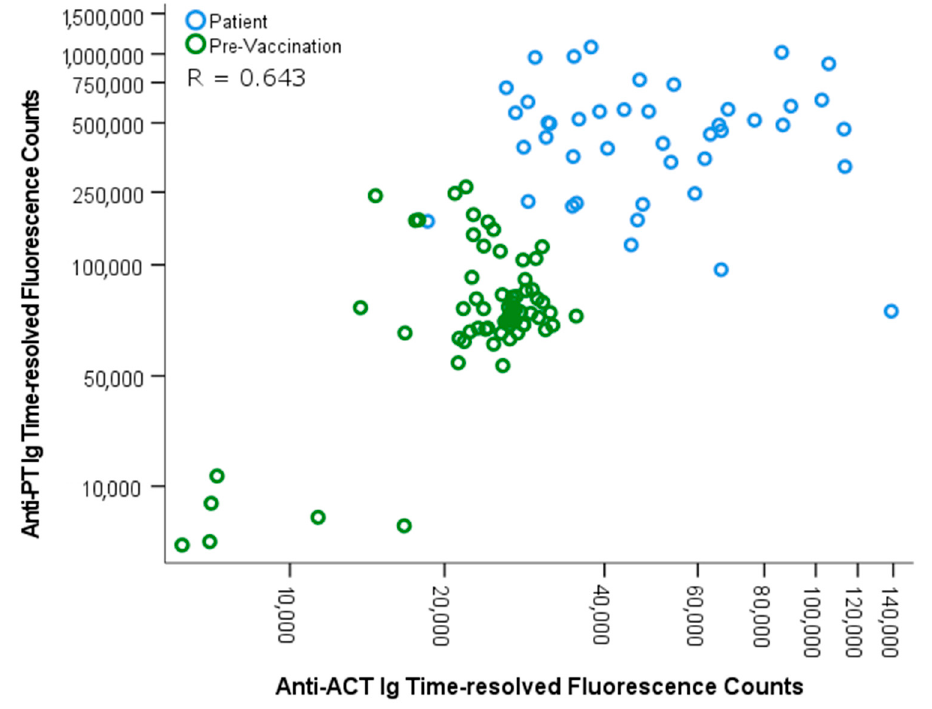
Figure 2. Spearman correlation between anti-PT and anti-ACT antibodies was evaluated with pertussis patients ( n = 46) and pre-vaccination samples ( n = 67) in the LF assay. One outlier from patients is limited out with over 300,000 ACT counts. LF: lateral flow.